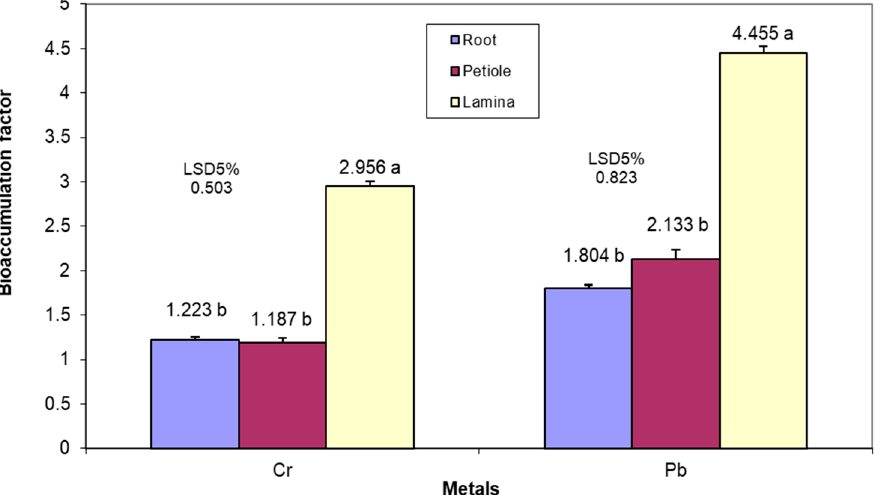
Figure 1. BAF of Cr and Pb in different organs of S. perfoliatum on heavy metal Ps. Error bars represent SE. Different letters (a, b) indicate significant differences ( p < 0.05) between plant organs.